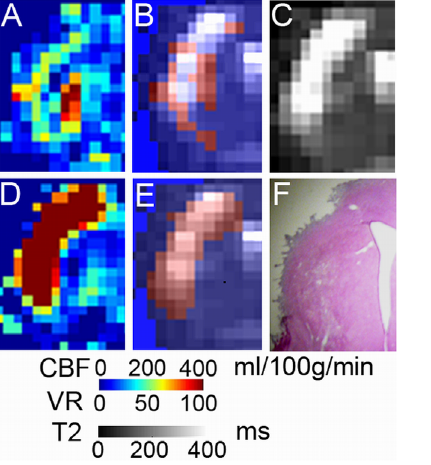
Figure 6. Increased density of blood vessels at perilesional regions with increased d14 vasoreactivity. RECA-1 immunofluo- rescence staining (red) with DAPI nuclear staining (green) compared in animals without (No VR + ) and with (VR + ) increased vasoreactivity on d14 (n=4 per group). Corresponding subcortical regions close to the infarct on d14 showed a higher density of RECA-1 signal. One example per group is shown on the right. White arrows point to the lesion. White line indicates 100 m m.